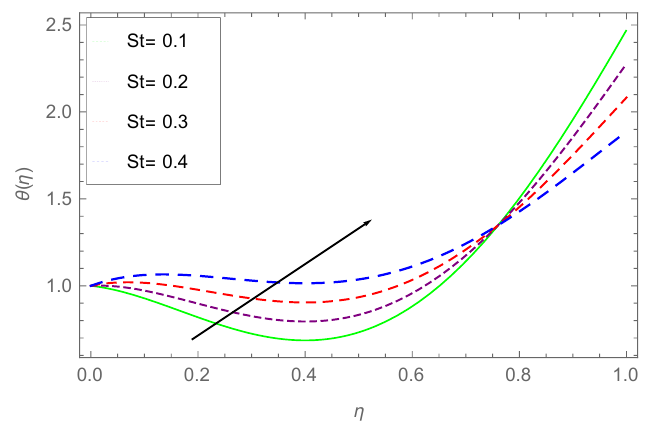
Figure 10. Impact of St on θ ( η ) , for β = 0.1, Nt = 0.8, Rd = 0.2, Nb = 0.5.